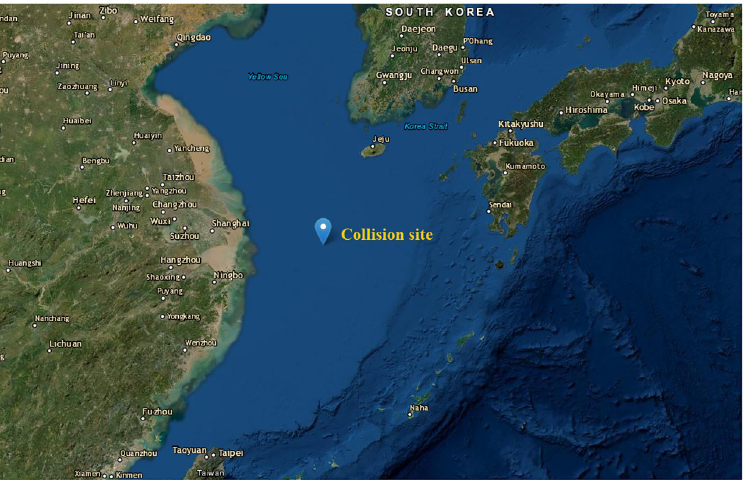
Fig 5. Geographical map of the approximate collision site and surrounding areas. Map services and data available from the U.S. Geological Survey.